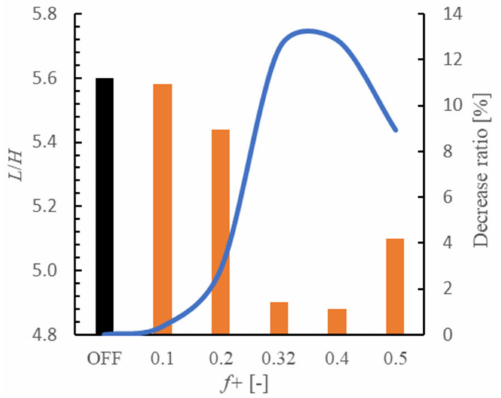
Figure 13. Reattachment length against dimensionless